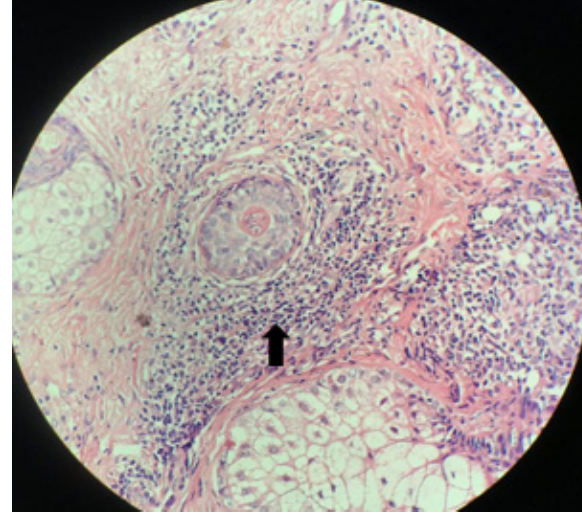
Figure 4. Presence of perifollicular inflammation (black arrow) in cutaneous DLE (magnification ×400). Note . DLE: Discoid lupus